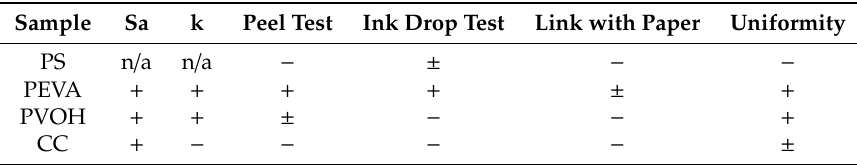
Table 2. Pre-coating blends